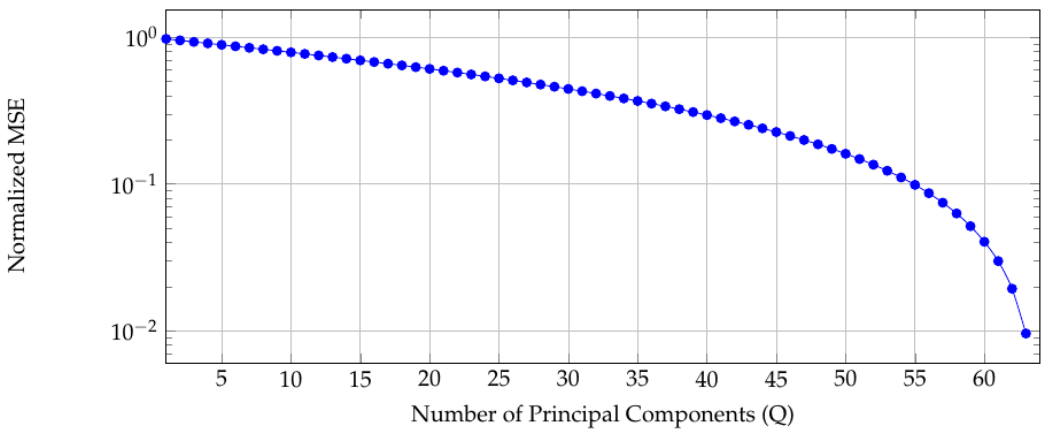
Figure 3. Log-lin plot of normalized mean square error when approximating the noise-free data with Q principal components.